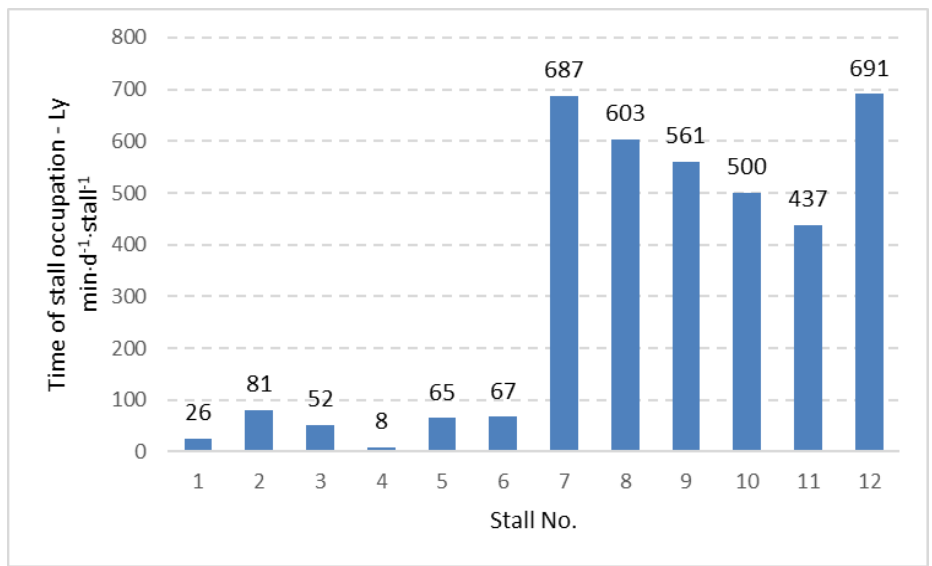
Figure 2. Distribution of time of occupation for lying (Ly) for individually considered stalls in the investigated pen.